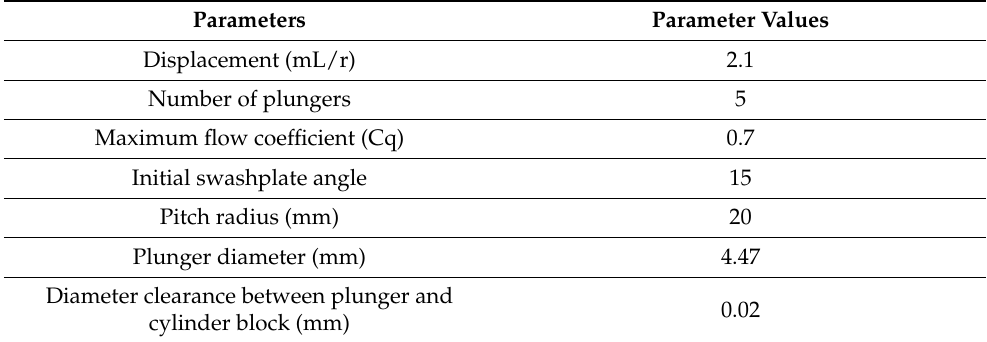
Table 1. Piston pump